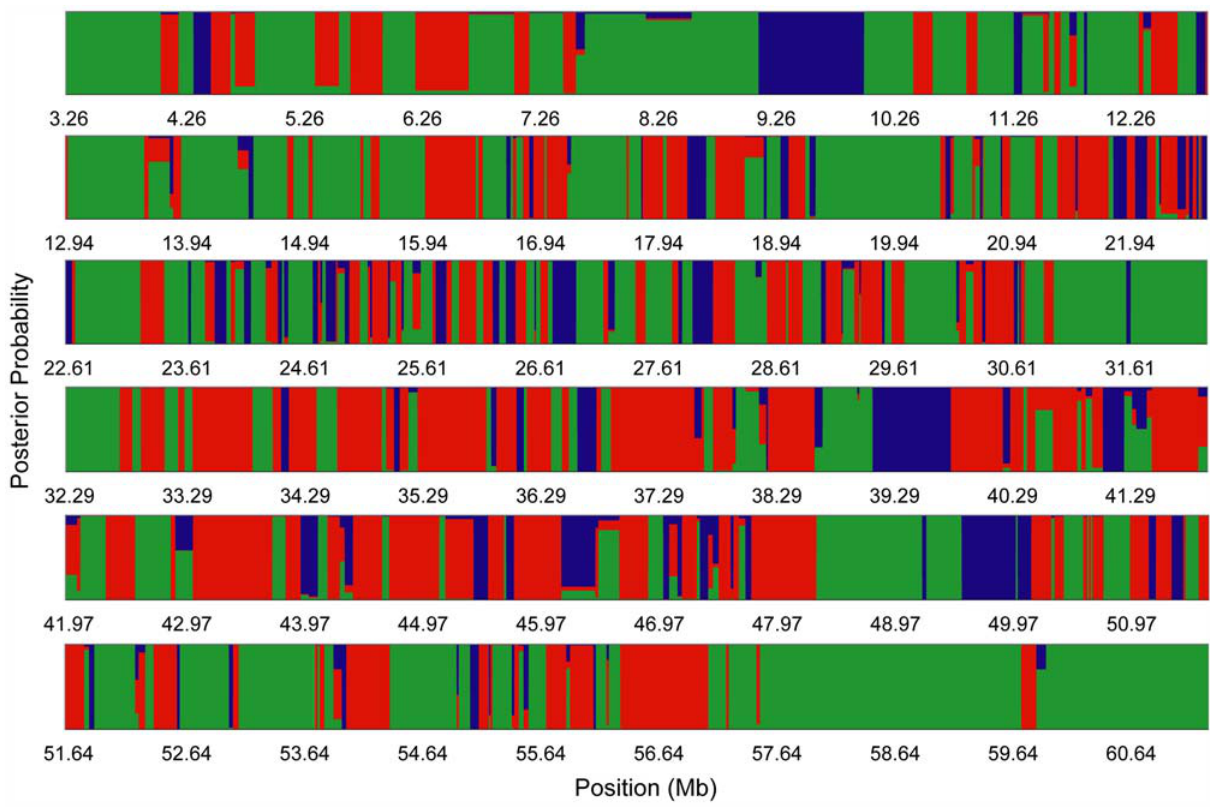
Figure 2. Fine-scale phylogenetic discordance. The posterior probability of each topology is mapped along chromosome 19 to characterize fine-scale patterns of discordance among the 410 loci. Many regions of the chromosome rapidly switch between phylogenetic histories and are characterized by loci that have a high posterior probability for a single topology. Colors correspond to the three topologies.